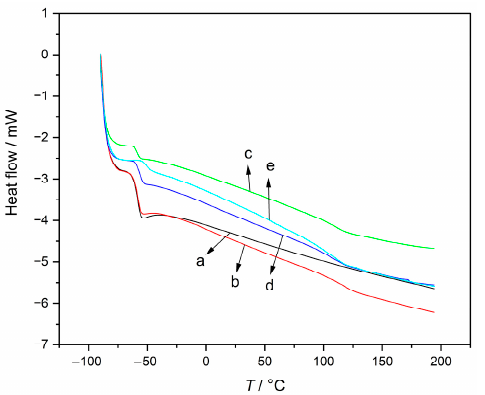
Figure 9. DSC curves of: ( a ) pure NR ( 2 NR) and semi-IPNs ( b ) 2 NRM 35 , ( c ) 2 NRM 55 , ( d ) 4 NRM 50 , and ( e ) 2 NRLM 50 .